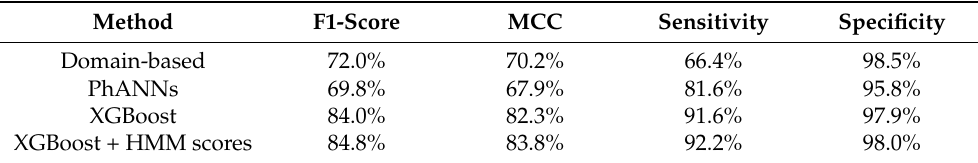
Table 3. Benchmarked F1-scores, Matthews correlation coefficient (MCC) scores, sensitivity, and specificity for our domain-based approach, our XGBoost classifier, PhANNs, and an XGBoost with HMM scores combination on the held-out test data.